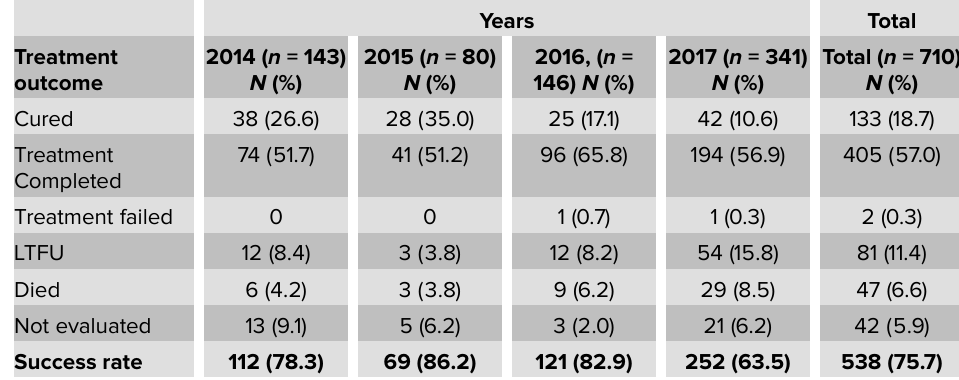
TABLE 2: TB treatment outcome of all TB cases registered in Al Kashafa, Wadsherify, and Shagarab refugee camps, Sudan, 2014–2017 ( N = 710).